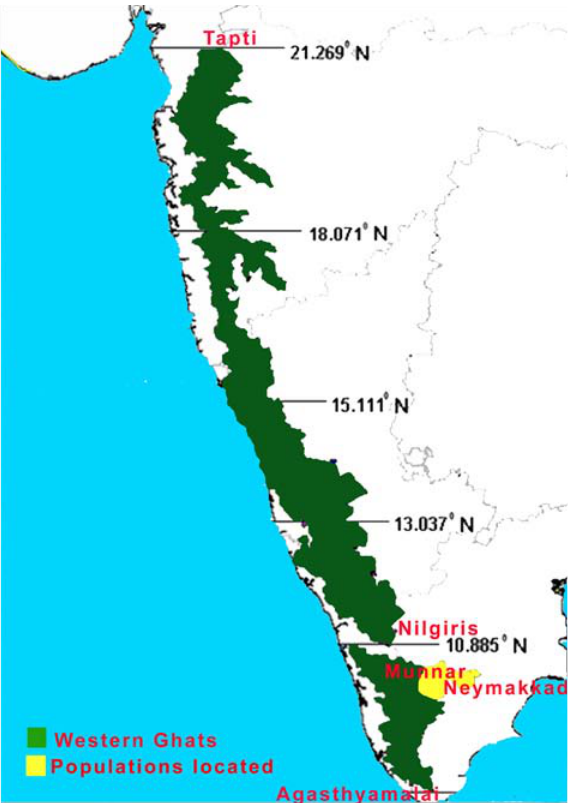
Figure 1. The study area in the Western